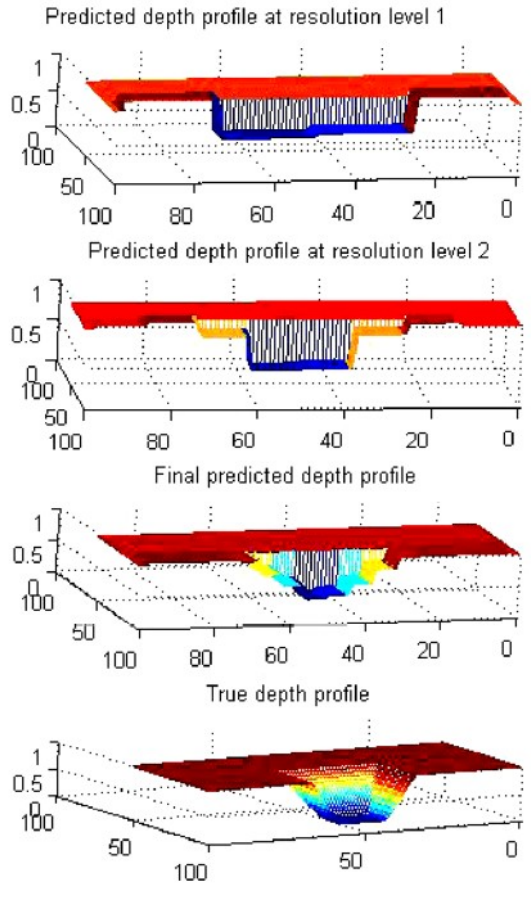
Figure 5. Image reconstruction results showing coarse to fine predication of the depth